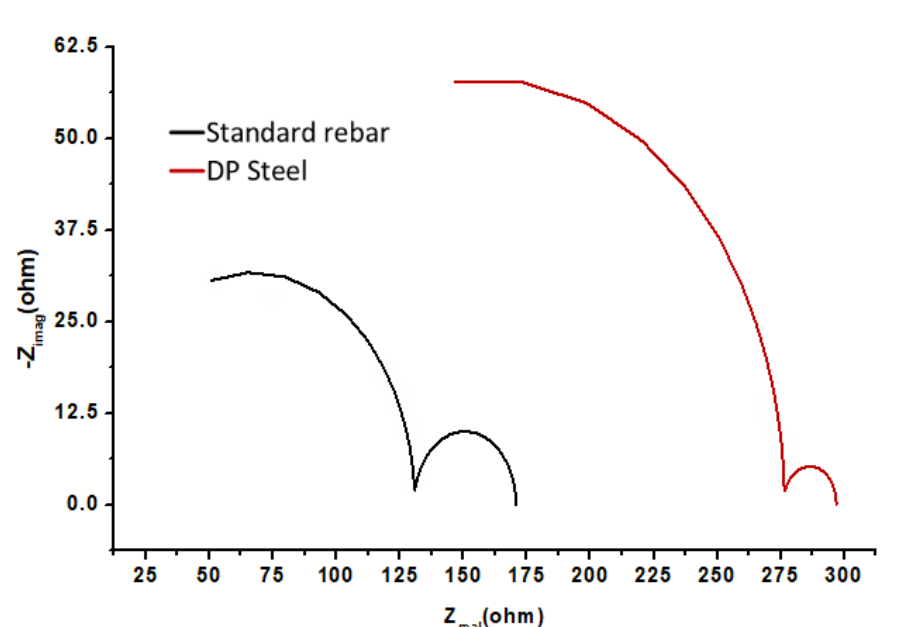
Figure 4. EIS results (Nyquist plots) for DP steel and standard rebar in 0.9 M NaOH (pH = 13.9) + 0.2% Cl − solution.